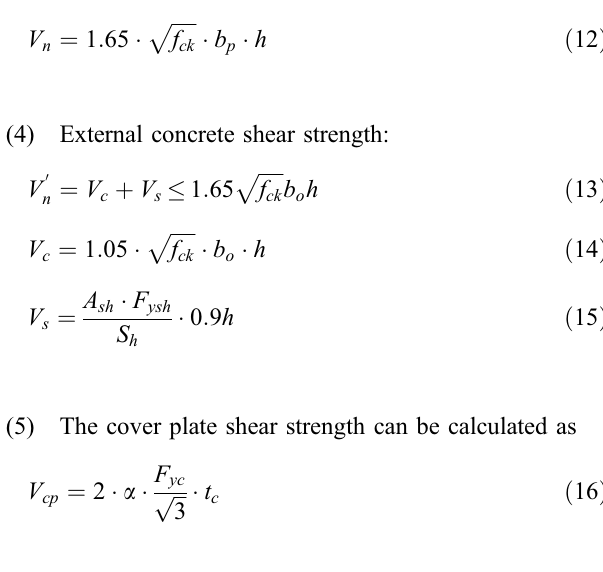
Table 4 Increases in shear strength due to the cover